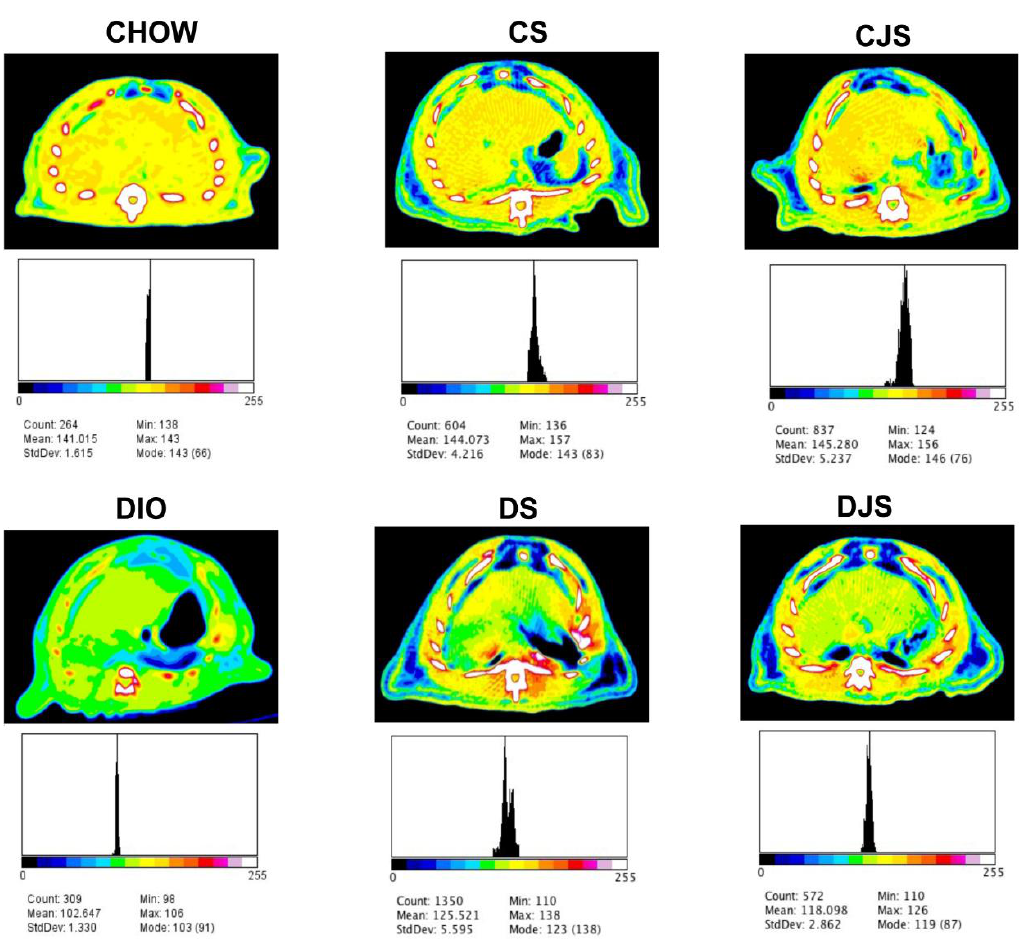
Figure 4. Computed tomography (CT) images evaluation with Image J software. The grayscale Digital Imaging and Communications in Medicine (DICOM) images obtained with CT were converted into pseudo-color images, which starts with the lowest density of black pixels (value of 0, air) and increases gradually, depending on the tissue density, to white pixels (value of 255, bone). The hepatic optical density for the different groups of rats ranged from 102.647 to 145.280, as reported below each image. The black peak in each histogram indicates the distribution of the optical density of the regions of interest investigated. CHOW—control rats with standard diet; CS—CHOW plus tart cherry seeds; CJS—CHOW plus tart cherry seeds and juice; DIO—diet-induced obese rats; DS—DIO plus tart cherry seeds; DJS—DIO plus tart cherry seeds and juice.